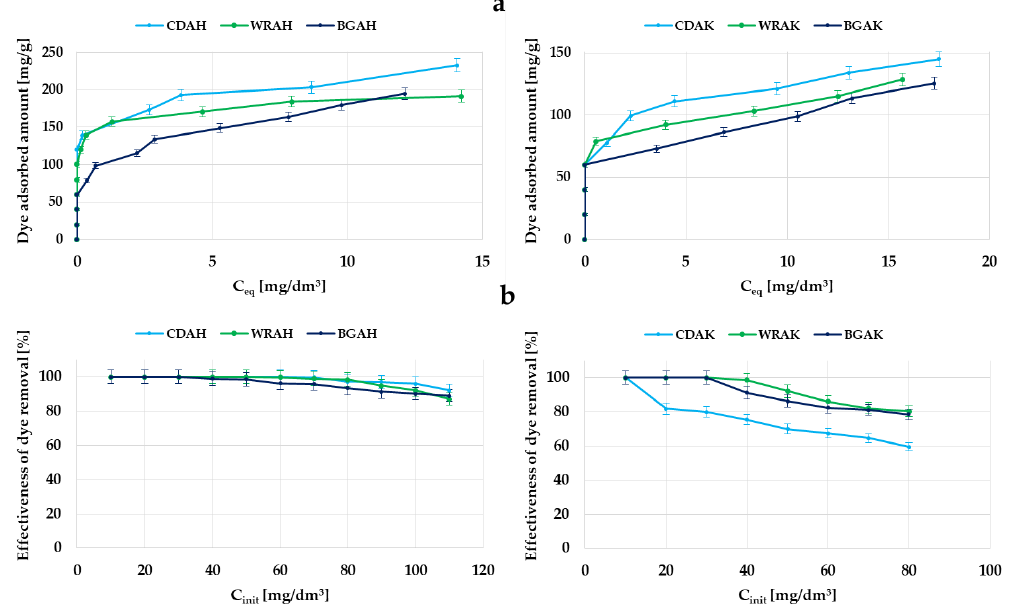
Figure 7. Adsorption of methylene blue on the samples activated with H 3 PO 4 and K 2 CO 3 : the equilibrium adsorption of dye molecules as a function of its equilibrium concentration ( a ); the effectiveness of dye removal from aqueous solutions ( b ).